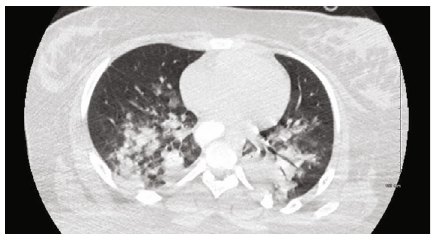
Figure 1: CT of the lungs demonstrates bilateral mid- and lower lung patchy consolidations and ground-glass opacities extending into the bilateral lung bases. Bilateral air bronchograms are